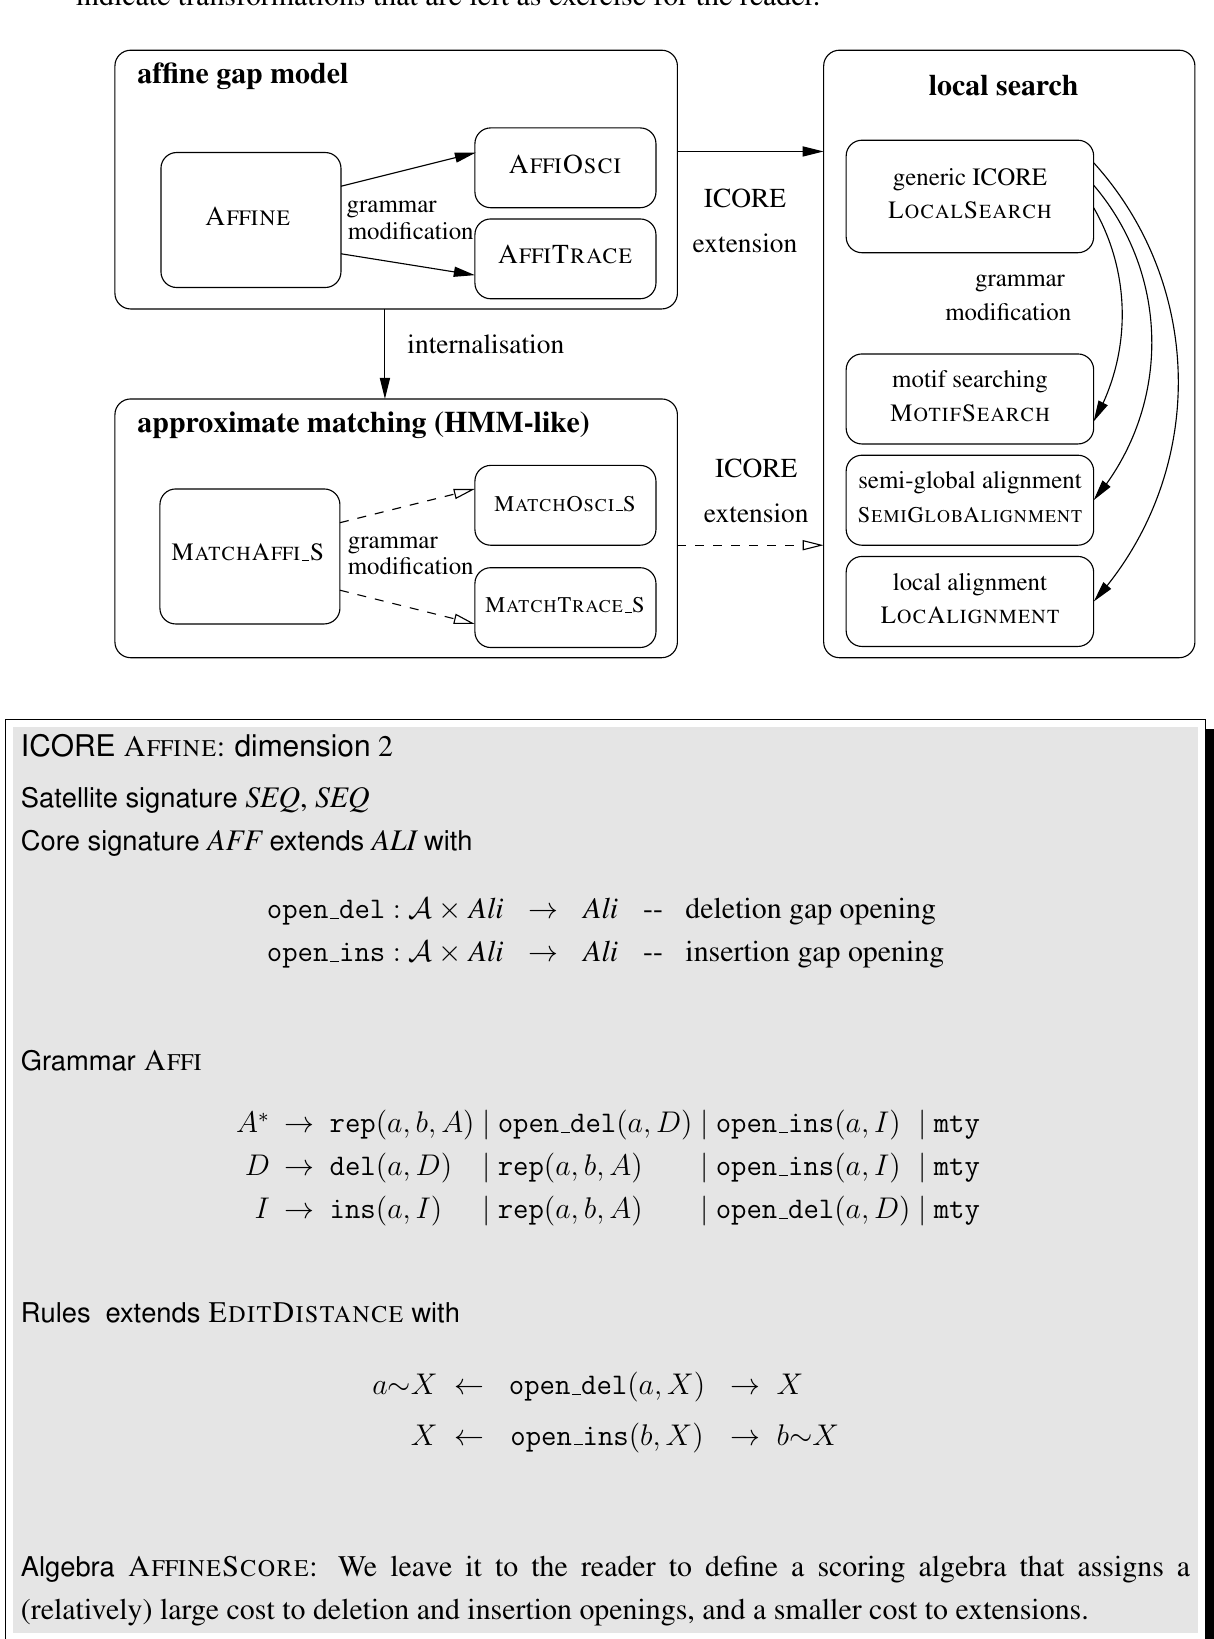
Figure 1. Overview of sequence analysis problems addressed in Section 5. Solid arrow lines indicate transformations between icores that are detailed in the text. Dashed arrow lines indicate transformations that are left as exercise for the